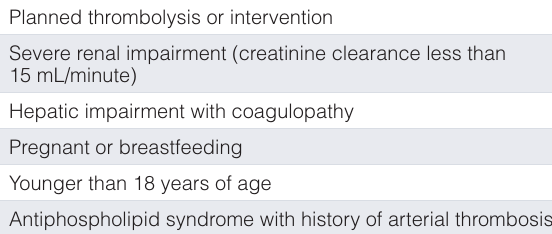
Table 1. Patients with venous thromboembolism who are not candidates for direct oral anticoagulants. Planned thrombolysis or